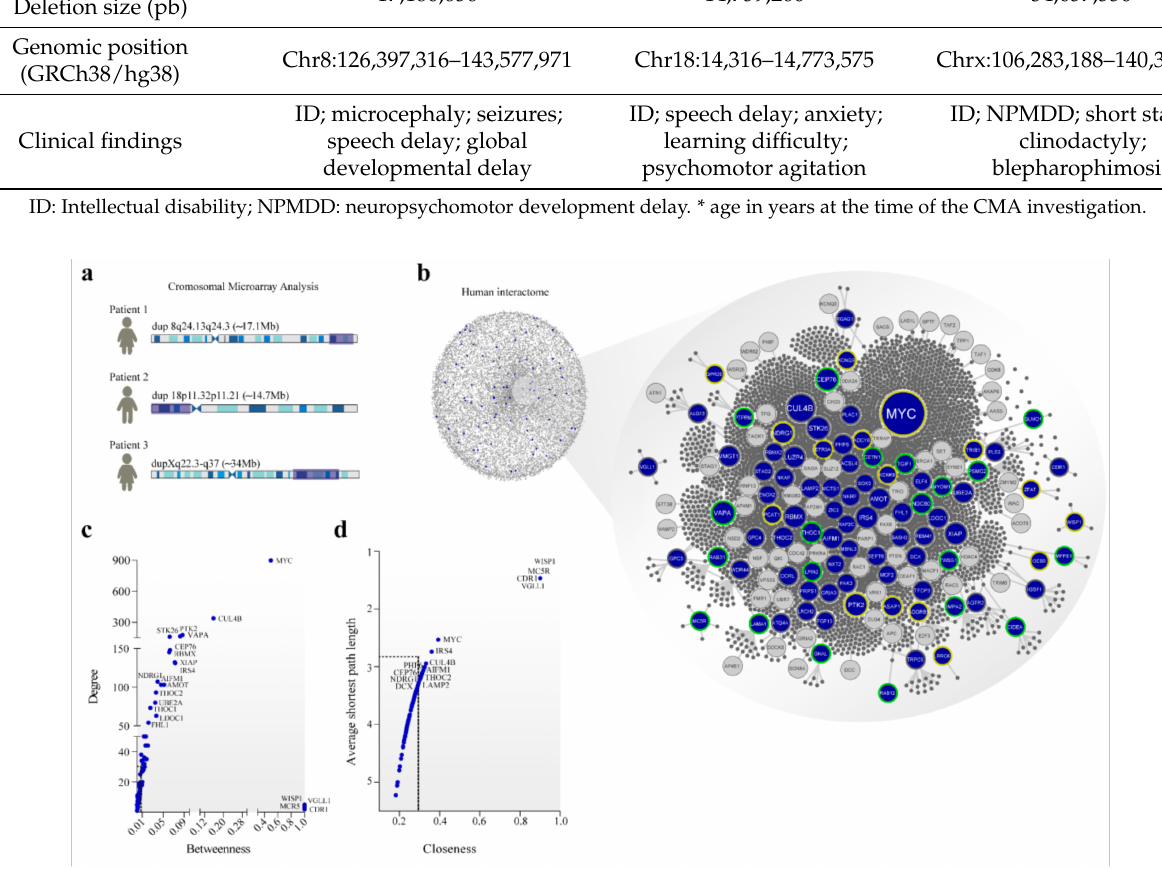
Figure 1. Cytogenetic to the interactome. ( a ) left: duplicated regions mapped by CMA in the patients; right: curated human interactome composed of 13,460 proteins and 141,296 interactions. In the network, proteins are nodes connected by interactions. ( b ) expanded duplication syndromes interactome (eDSi) with 3016 proteins and 4330 interactions. Blue nodes are protein-coding genes from duplicate regions; grey nodes are ID-genes. Node border colors represent the origin of duplication: dup 8q24.13q24.3 in yellow; dup 18p11.32p11.21 in green; dupXq22.3-q27 in grey. Node size is related to the number of connections (degree). ( c ) Topological parameters with degree and betweenness distribution and values of ( d ) average shortest path length and closeness for duplicated protein-coding genes in eDSi. Dashed lines in black indicate the average of these parameters for human